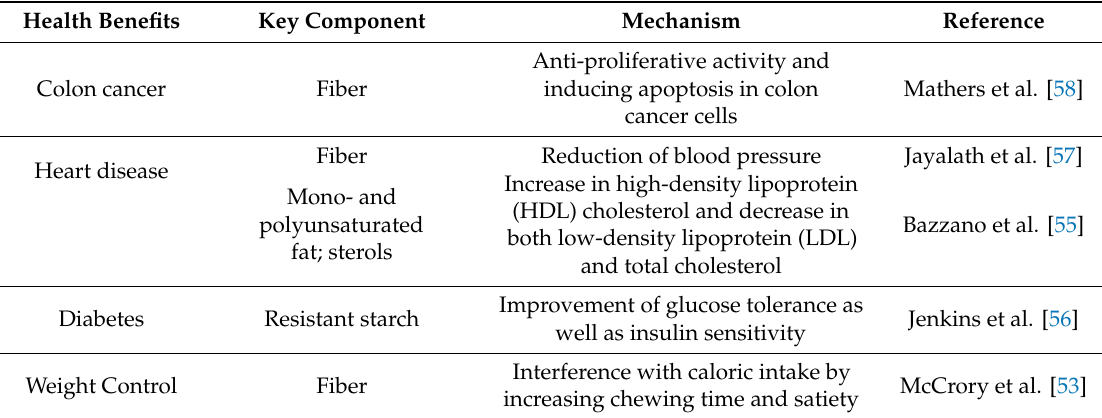
Table 2. Potential health benefits of pulses and their